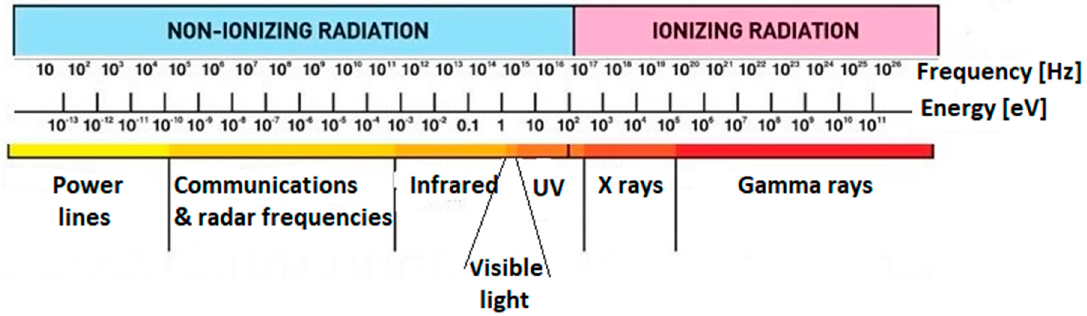
Figure 3. Non-ionizing and ionizing radiation ranges: frequency and energy.